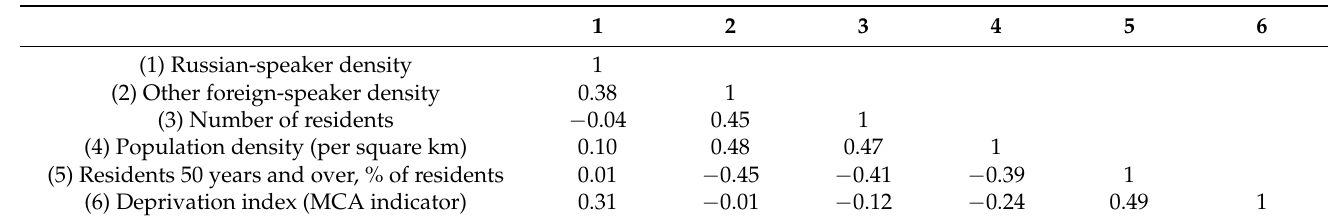
Table 2. Correlation matrix of the neighbourhood